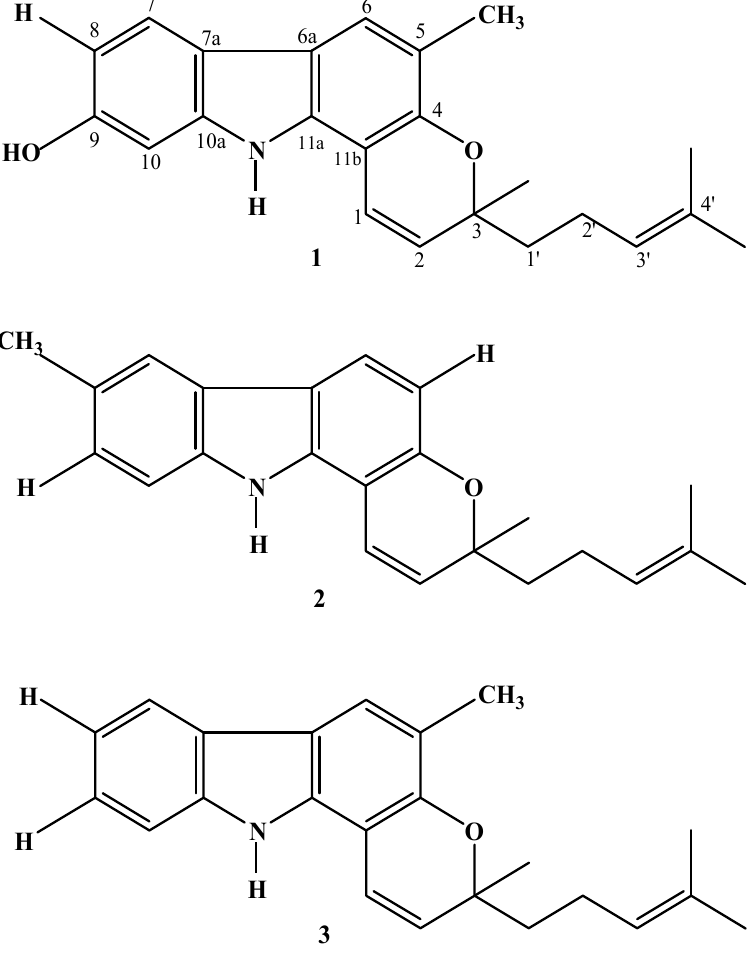
Figure 1. Chemical structures of carbazole alkaloids [mahanine ( 1 ), mahanimbicine ( 2